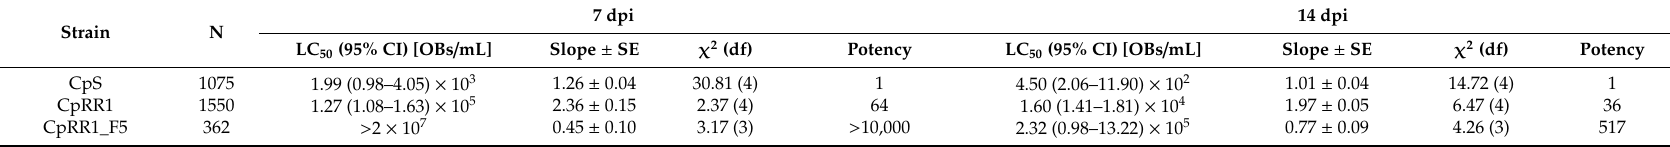
Table 2. Median lethal concentration (LC 50 ) observed for the resistant codling moth strains CpRR1, CpRR1_F5 and the susceptible strain of CpS infected with CpGV-M. Given are the total number (N) of tested L1 larvae, the LC 50 values at 7 and 14 days post infection (dpi) and their the 95% confidence intervals (CI), the slope and standard error (SE) of the probit line as well as χ 2 value and degree of freedom (df), as well as the potency (LC 50 resistance strain / LC 50 CpS ) of the di ff erent